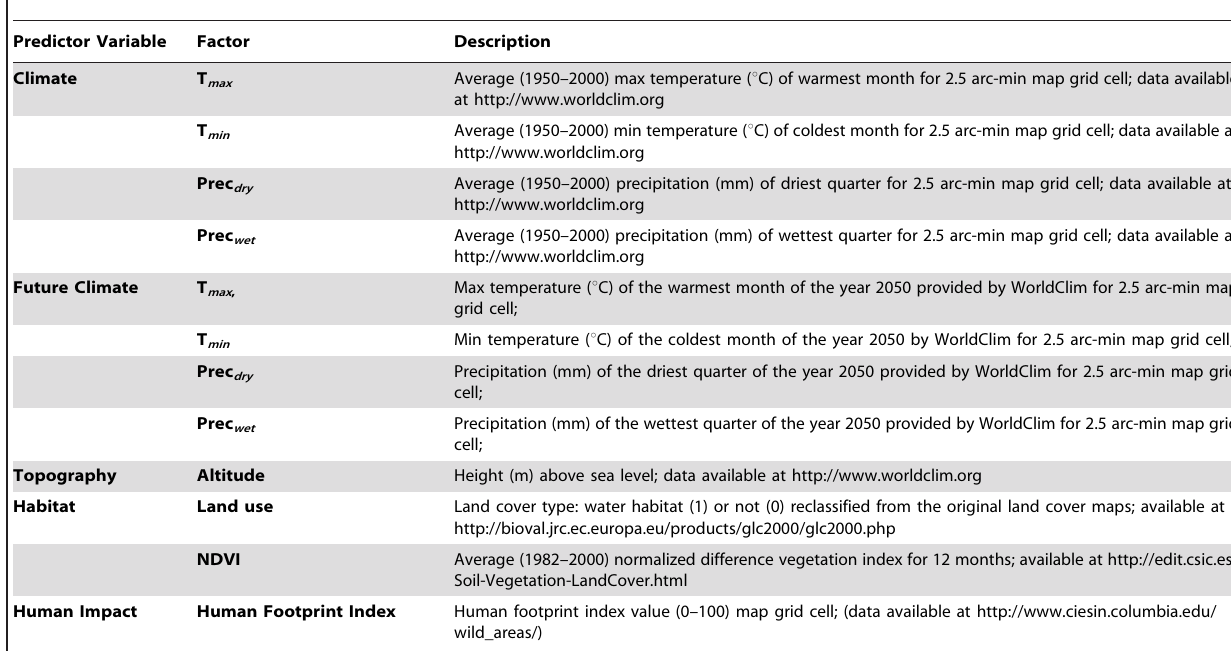
Table 1. Description of factors included as predictor variables to model the effects of climate change on potential global distributions of the invasive P. clarkii